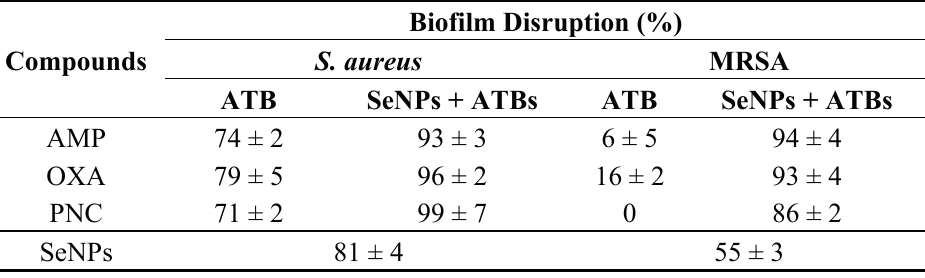
Table 1. Percentage disruption of biofilm after treatment of antibacterial component (ATBs, SeNPs + ATBs) after 24 h (Figure